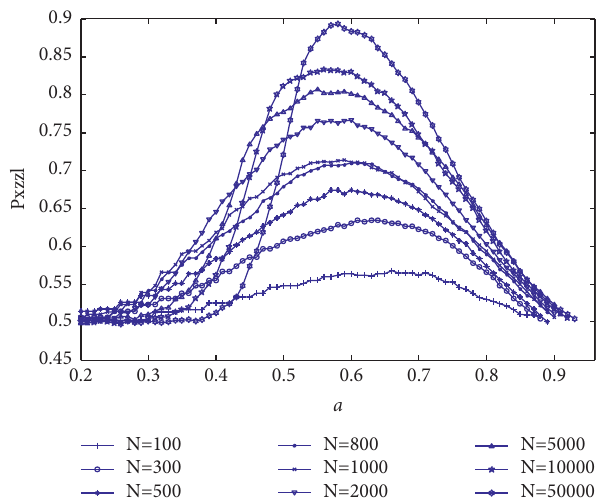
Figure 3: Judging accuracy of the existence test for long